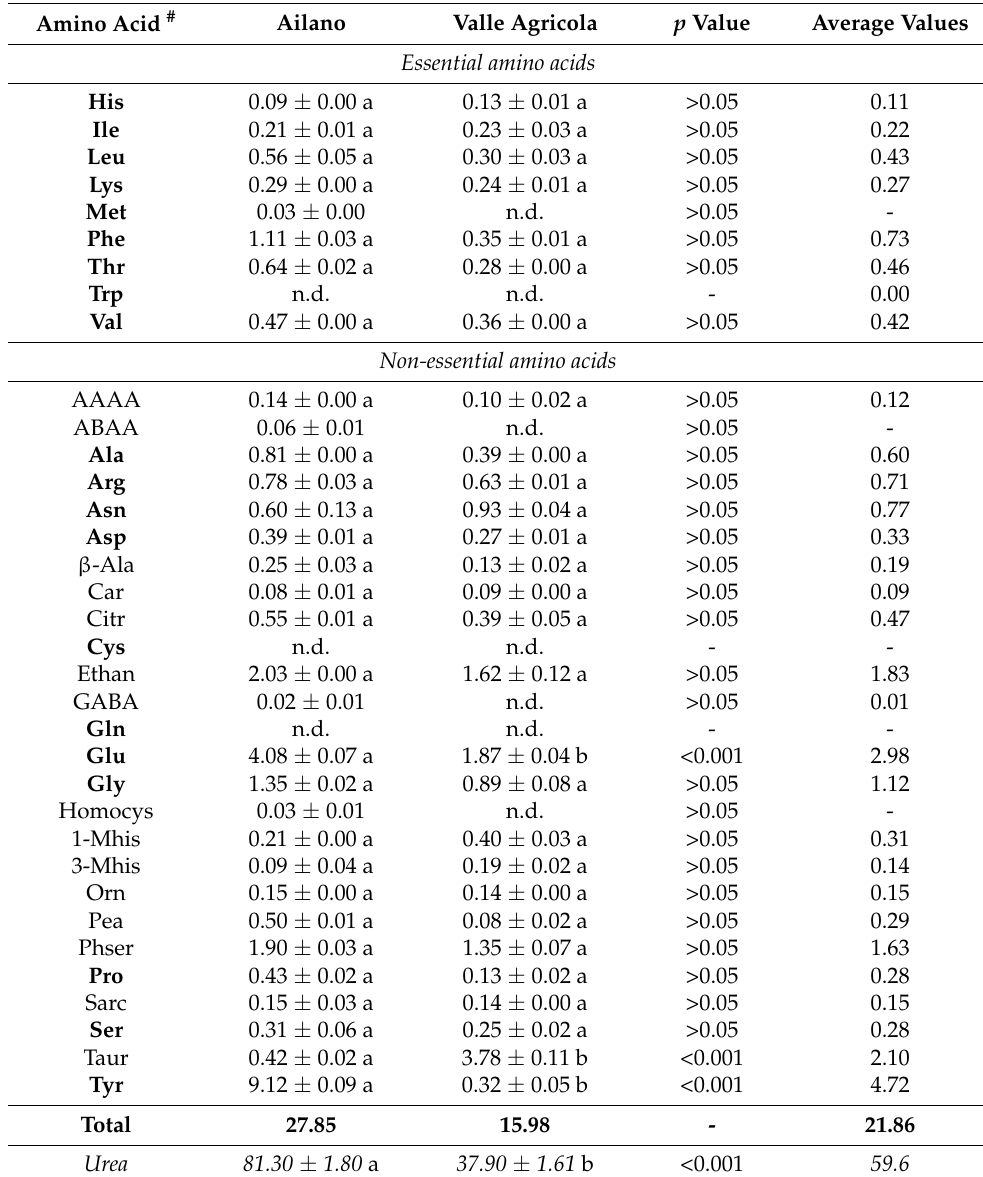
Table 4. Free amino acid composition of sheep raw milk from ‘Ailano’ and ‘Valle Agricola’. Values are means ( ± SD) and are expressed as mg per 100 g of milk. See Section 2.2 of Materials and Methods section for more